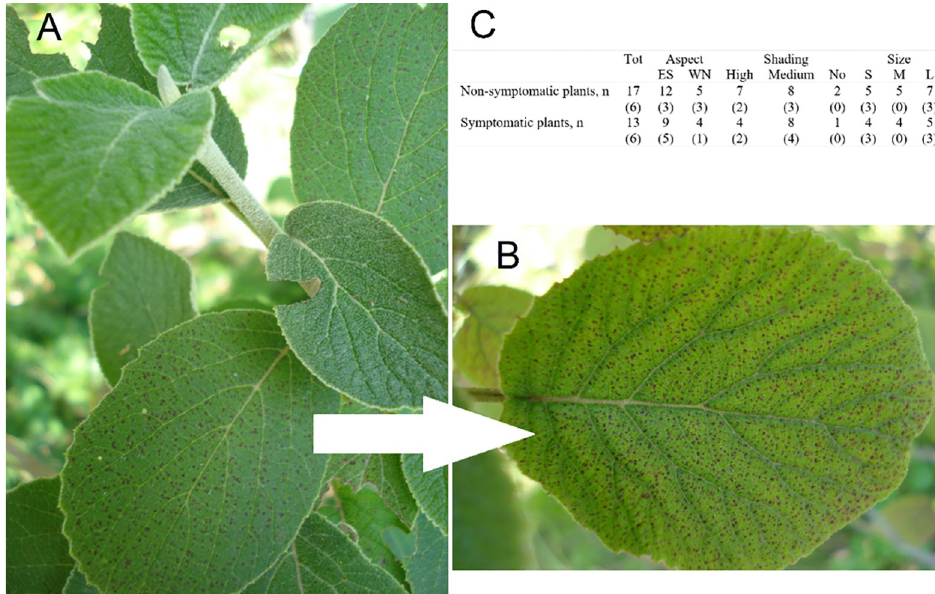
Fig 3. Example of VFS observed in V . lantana (A and B). In C, number of non-symptomatic and symptomatic V . lantana plants assessed at the Bleggio site, sorted for aspect, shading and size classes; the correspondent number of the subset plants, selected for the leaf trait investigation, is reported in brackets.